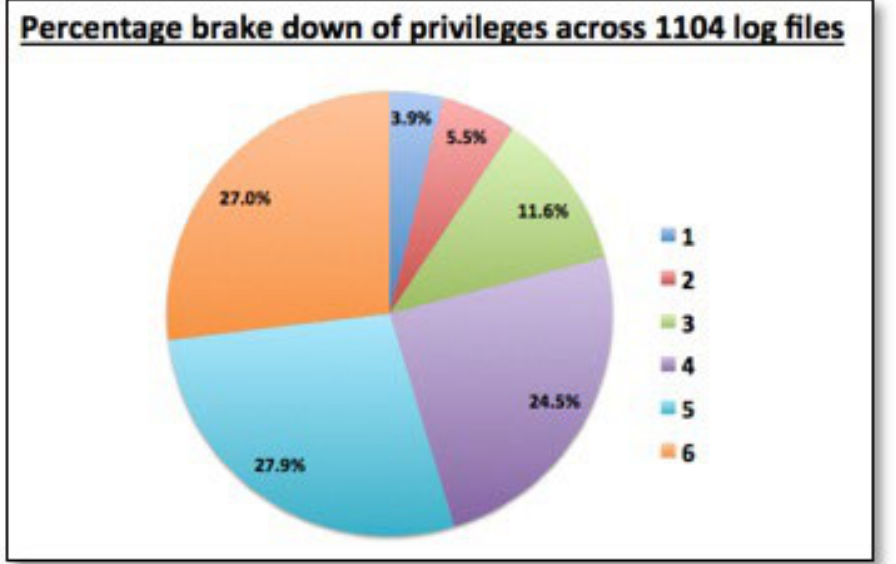
Figure 4: Privileges brake down per log